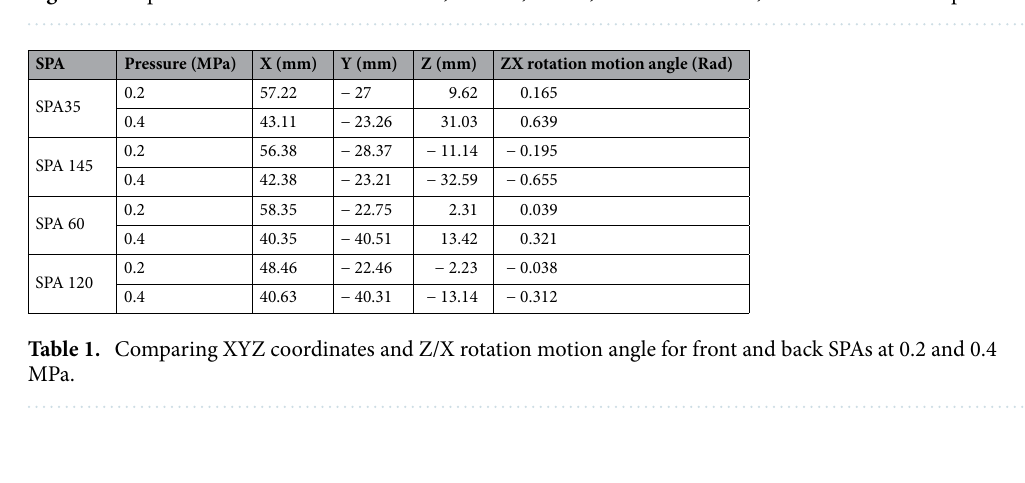
Figure 6. Experimental versus FEA for SPA35, SPA145, SPA60, and SPA120 for X, Y and Z coordinates points.